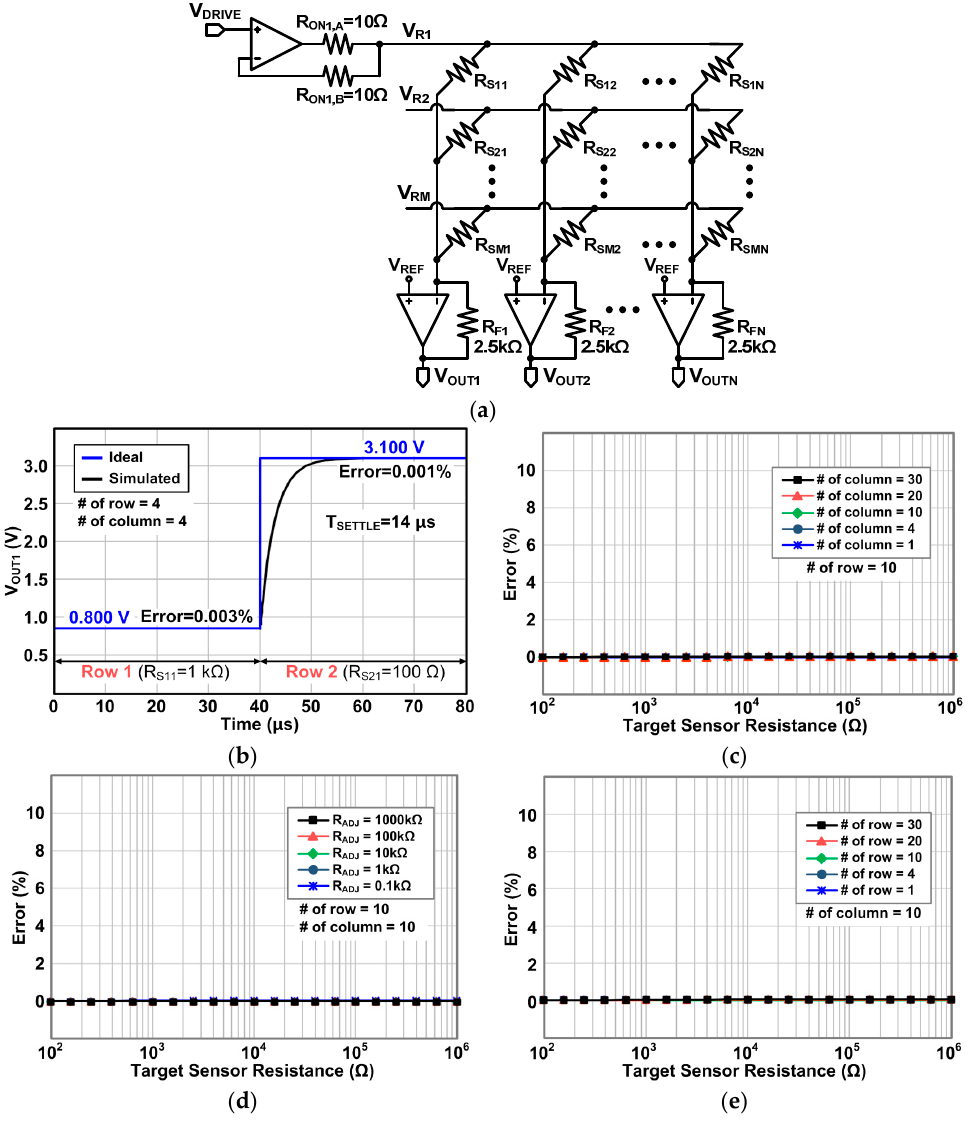
Figure 12. ( a ) Schematic for the simulations of the proposed row driver Type III; ( b ) transient simulation results; ( c ) output errors as a function of the sensor resistance with different column numbers; ( d ) output errors as a function of the sensor resistance with different adjacent sensor resistance(R ADJ ); and ( e ) output errors as a function of the sensor resistance with different row numbers.